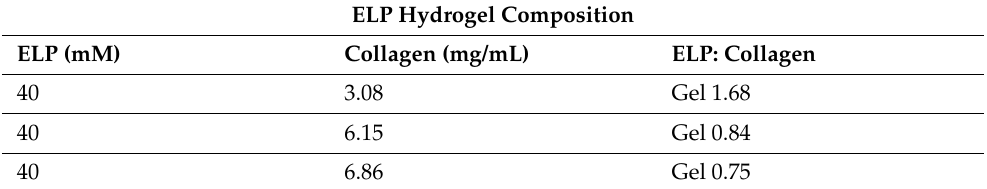
Figure 1. The design and application of ELP-based hydrogels for local treatment of brain tumors. ELP–DOXO hydrogels are initially in the sol state can be injected directly into the surgical resection cavity where they polymerize into a gel state and elute an anticancer drug over time, killing remaining cancer cells and preventing recurrence. Table 1. Compositions of three ELP hydrogels compared in these studies. The designating number refers to the molar ratio of ELP to collagen (higher numbers have more molecules of ELP per collagen molecule).